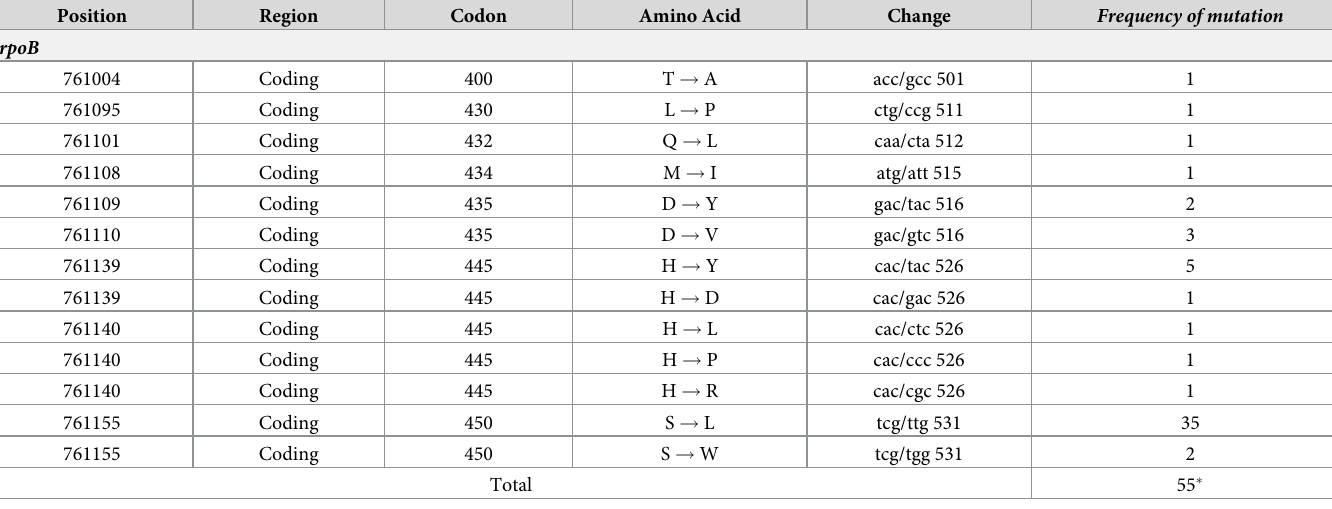
Table 2. Rifampicin mutations detected by WGS from isolates of Mycobacterium tuberculosis circulating in Veracruz, Mexico. Position Region Codon